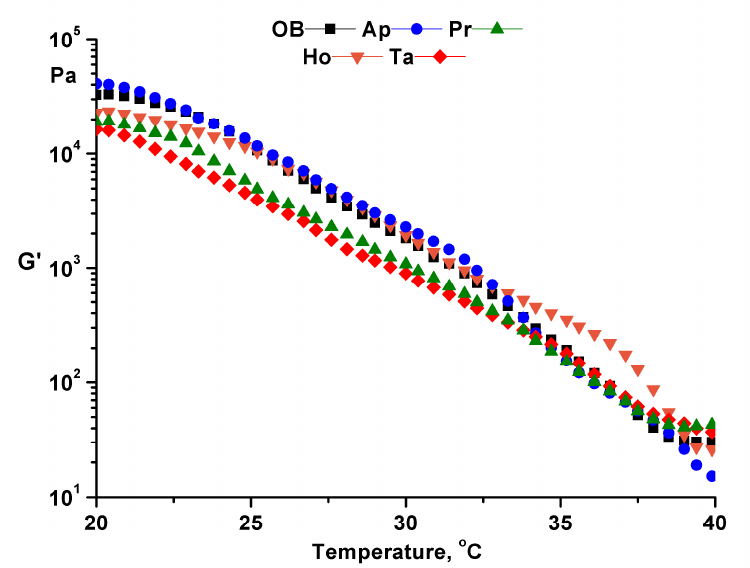
Figure 4. Temperature test for analyzed ointments. OB—ointment base, Ap—ointment base + apilarnil, Pr—ointment base + propolis, Ho—ointment base + honey, Ta—ointment base + mixture of bee